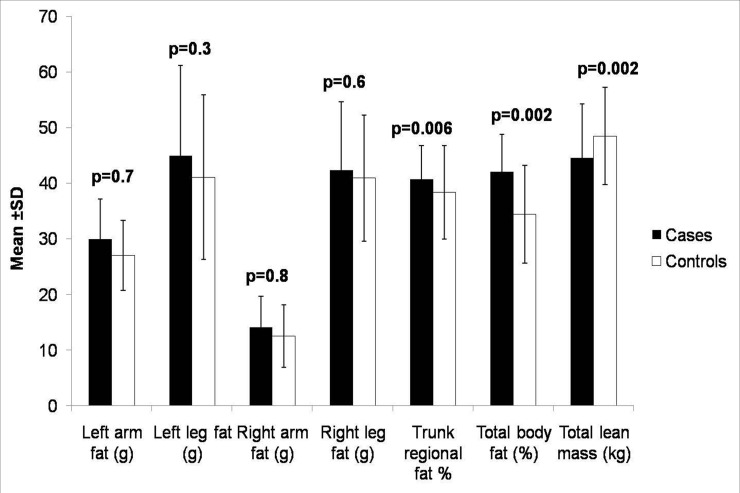
Body composition between cases (n = 162) and controls (n = 173) was estimated by using whole body dual-energy X-ray absorptiometry scan.